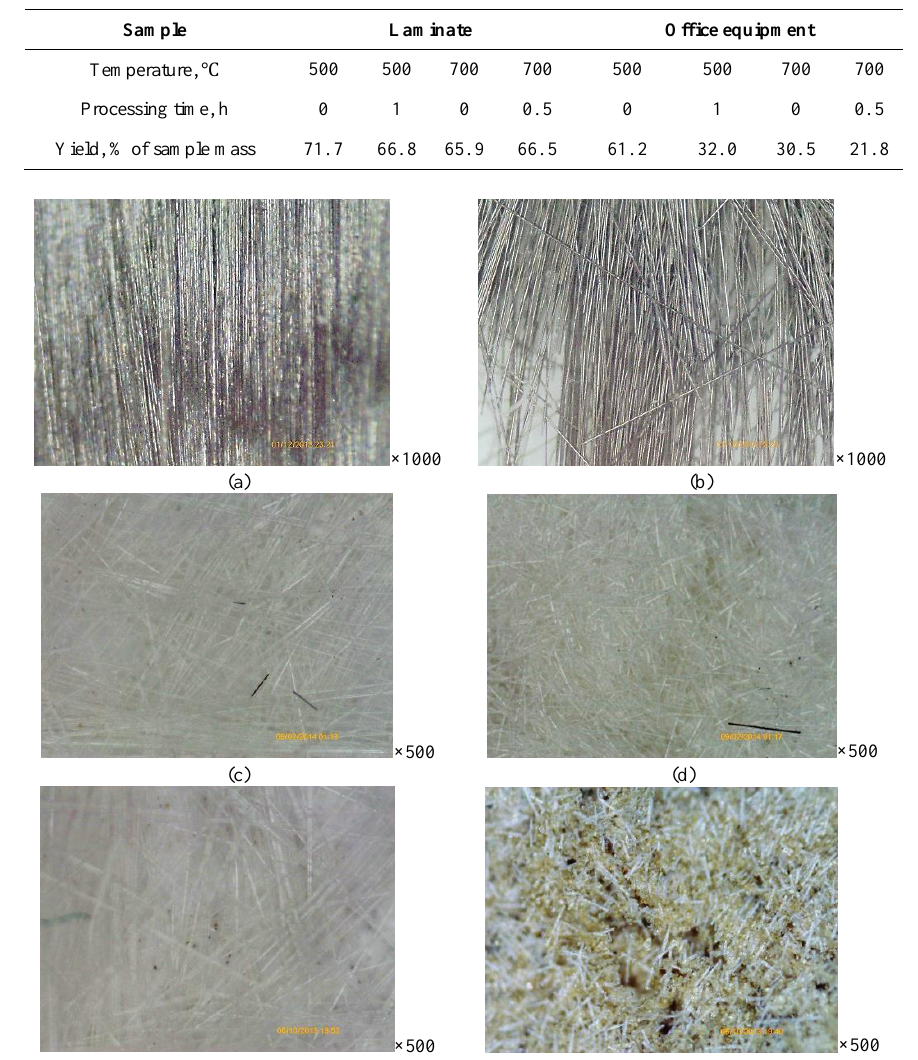
Figure 5. Micrographs of thermally recovered CFs from U-3 (a–500°C, b–700°C) and glass fibers (d–laminate, 500°C; e